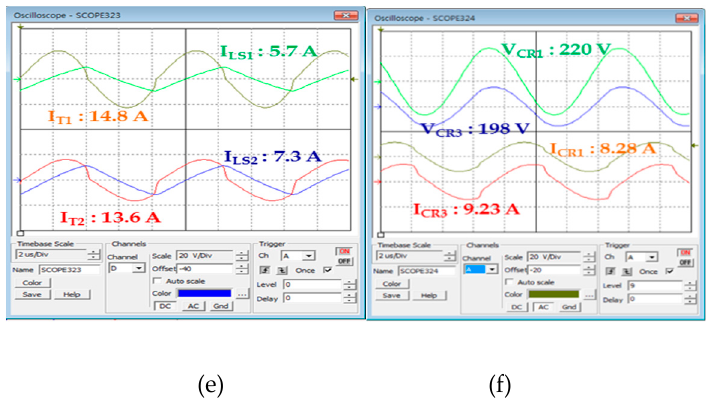
Figure 11. Simulation result for the auto-balancing converter. ( a ) Input and output voltages and